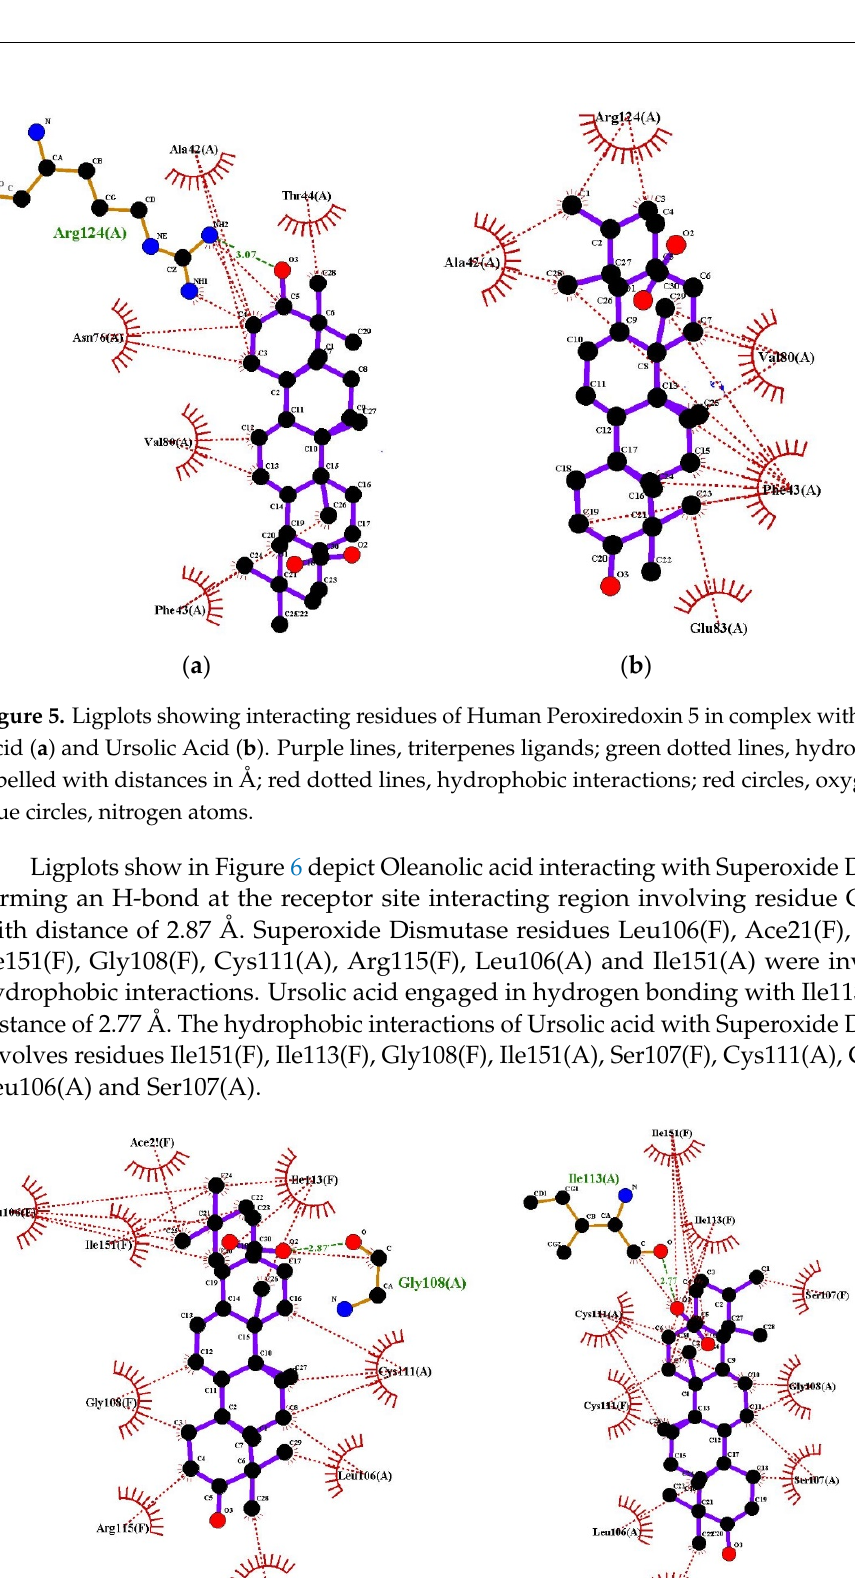
Oleanolic Acid ( a ) and Ursolic Acid ( b ). Purple lines, triterpenes ligands; green dotted lines, hydrogen